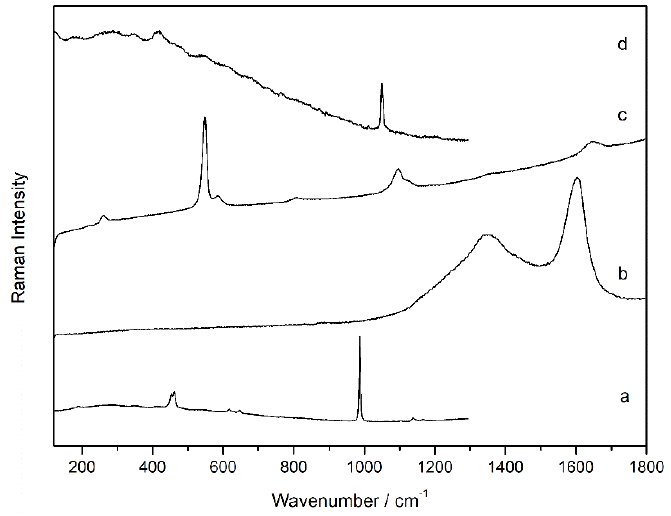
Figure 6. Raman spectra recorded in the original grey layer (sample SUBS-3b): barium sulfate ( a ), carbon ( b ), ultramarine blue ( c ), and lead white ( d ).